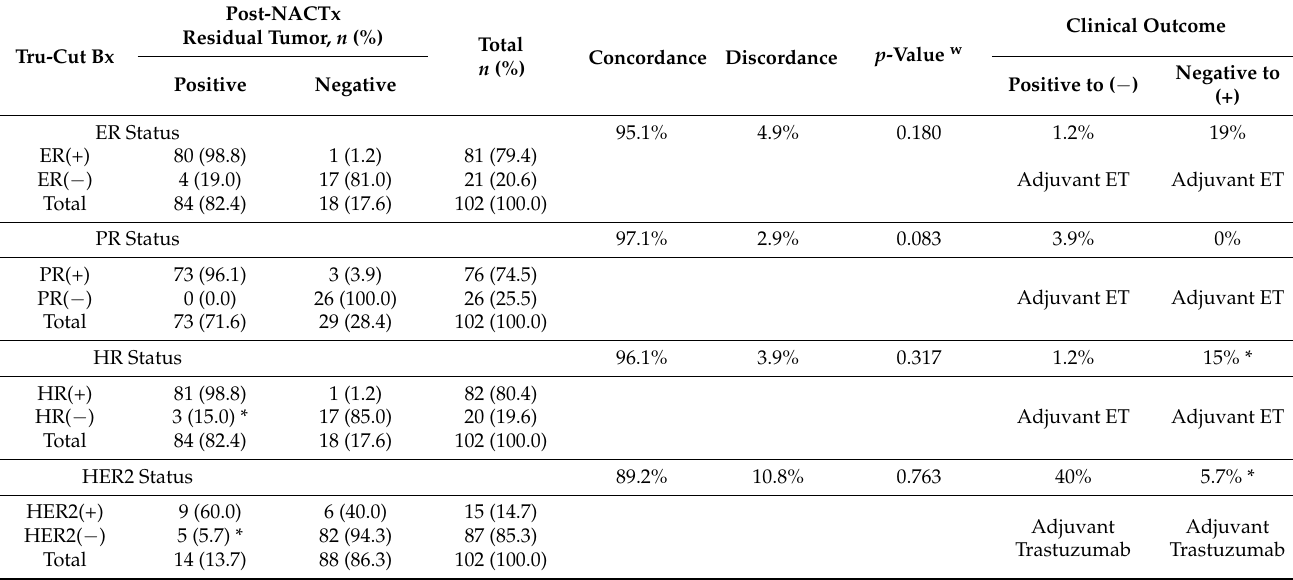
Table 2. ER, PR, HR, and HER2 status of the patients before and after NACTx and clinical outcomes.